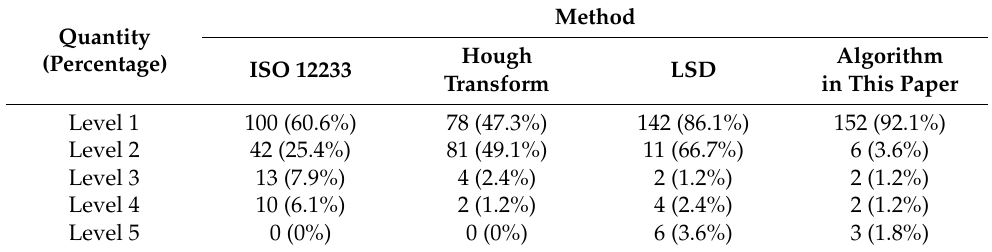
Table 5. Distribution and proportion of the grade of the test results by different methods.